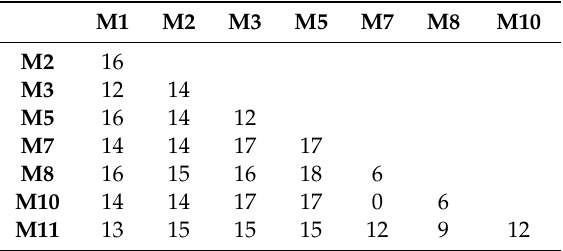
Number of di ff erent observations between di ff erent accessions characterized with 30 OIV